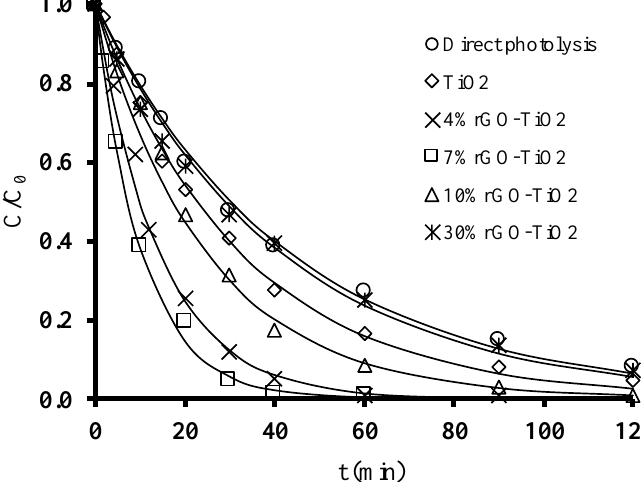
Figure 12. Photodegradation kinetics of EtP under UV radiation in the presence of rGO-TiO 2 composites as a function of treatment time. [EtP] 0 = 0.30 × 10 − 3 mol / L, [catalyst] 0 = 0.7 g / L. Table 8. Experimental results obtained from EtP photodegradation under UV radiation in the presence of di ff erent rGO-TiO 2 composites [EtP] 0 = 0.30 × 10 − 3 mol / L, [catalyst] 0 = 0.7 g / L.